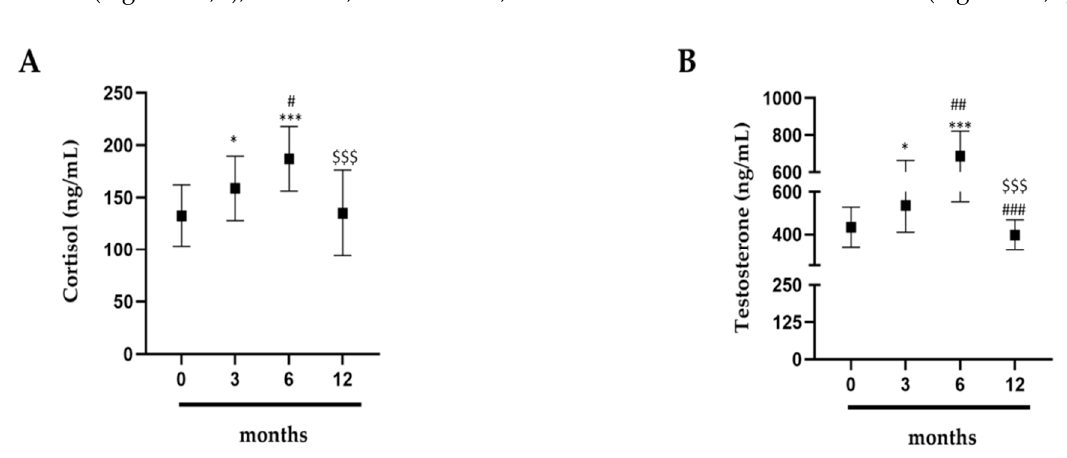
Figure 3. Hormonal dosages. ( A ) Cortisol; ( B ) testosterone. Evaluation of hormones in 15 professional basketball athletes at 0, 3, 6, and 12 months. The data are expressed as the means ± SDs. The significance was determined by the Student’s t -test: * ( p < 0.05), ( p < 0.01), and *** ( p < 0.001) represent significance compared to 0 months; # ( p < 0.05), ## ( p < 0.01), and ### ( p < 0.001) represent significance compared to 3 months; ( p < 0.05), ( p < 0.01), and $$$ ( p < 0.001) represent significance compared to 6 months.